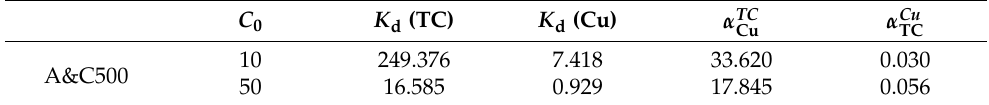
Table 2. The parameters of distribution and selectivity of A&C500 for Cu and TC under the binary system. C 0 K d